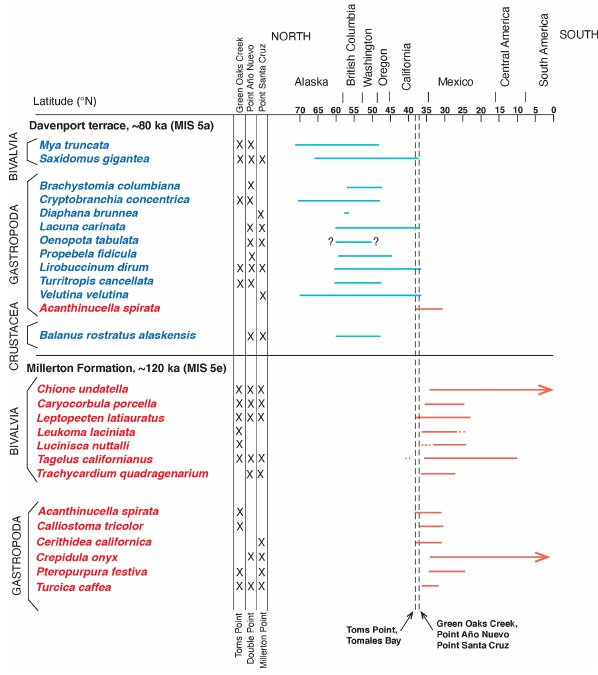
Figure 13. Modern geographic ranges of extralimital and northward- or southward-ranging fossil mollusks found in ∼ 80000yrBP marine terrace deposits at Green Oaks Creek, Point Año Nuevo, and Santa Cruz, California, and the ∼ 130000yrBP Millerton Formation at Toms Point, Tomales Bay, California. Ages are from Grove et al. (1995) for the Millerton Formation at Toms Point and Muhs et al. (2006) for the other localities. Fossil data for the Millerton Formation are from Johnson (1962); Davenport ter- race fossil data are from Addicott (1966) and Muhs et al. (2006). Modern species names and geographic ranges updated by the au- thor from Abbott and Haderlie (1980), O’Clair and O’Clair (1998), and Coan et al. (2000).